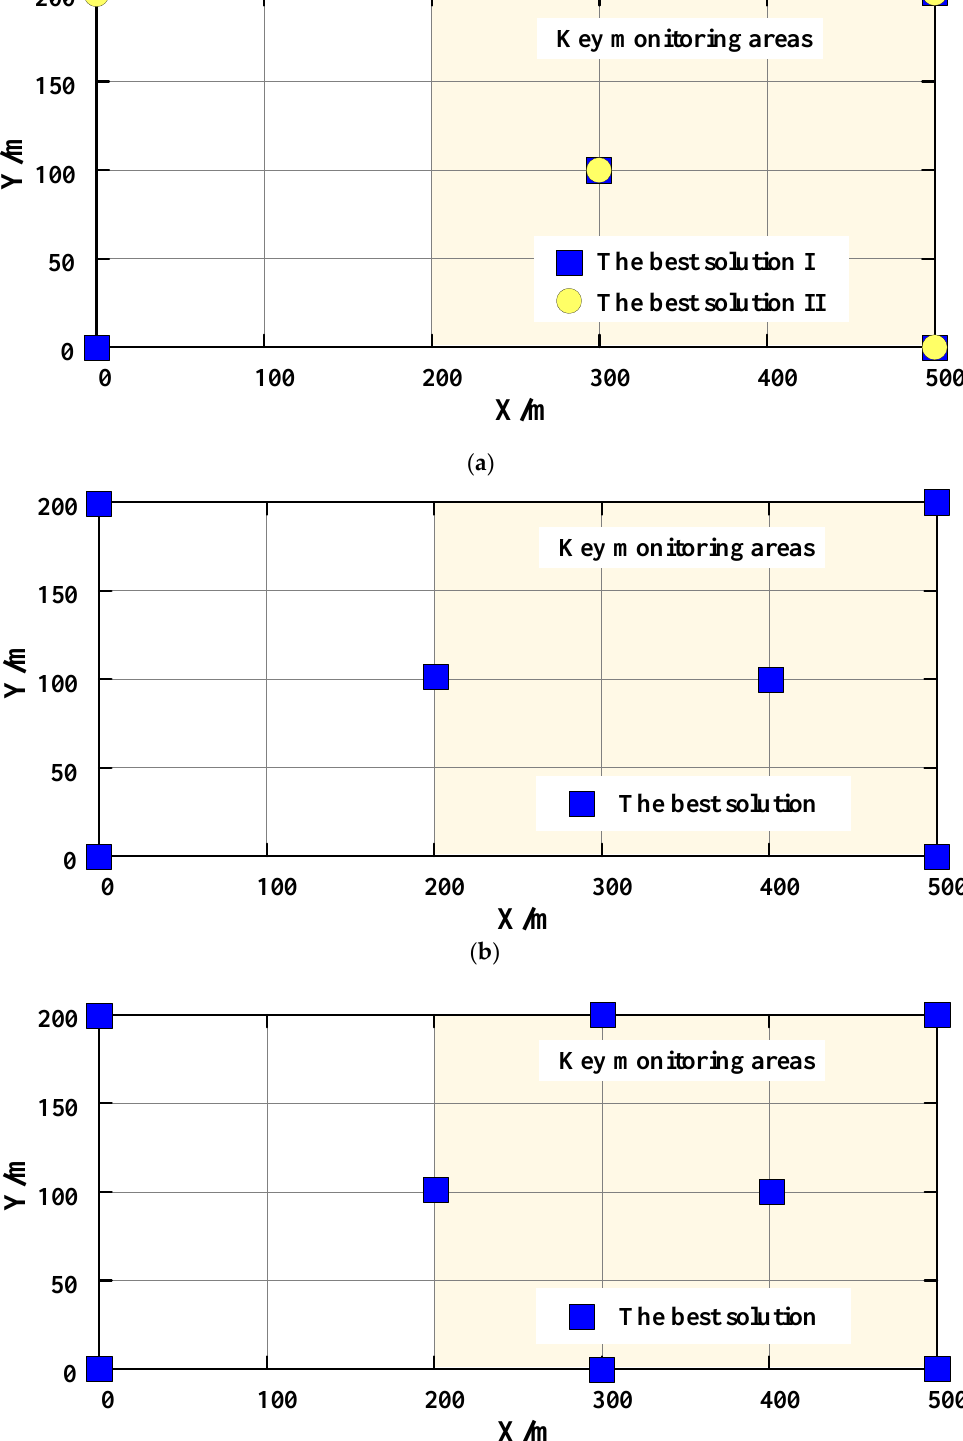
Table 3. Comparison of optimization results of different algorithms.